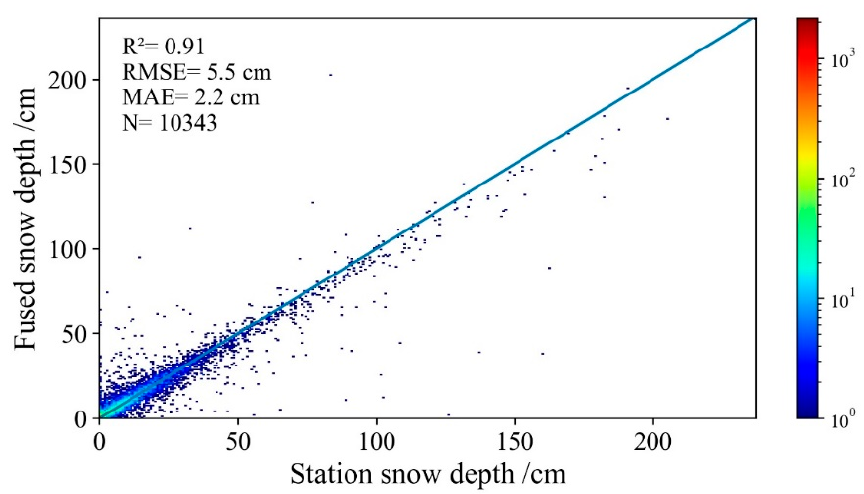
Figure 3. Average uncertainties of five commonly used snow depth datasets and the fused snow depth dataset compared with in situ observations from September to May from 2002 to 2011. Each sub-figure shows a different assessment index: ( a ) Coefficient of determination (R 2 ); ( b ) Root Mean Squared Error (RMSE) and ( c ) Mean Absolute Error (MAE). The fused snow depth values are distributed near the 1:1 line (Figure 4).